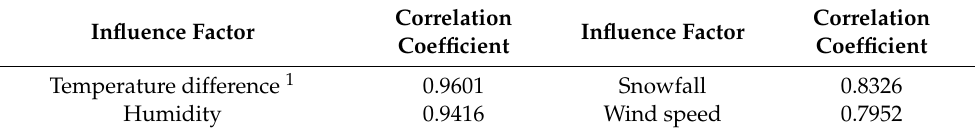
1 Table notes: In this paper and Table 1, “temperature difference” refers to the difference between human thermal comfort temperature and actual temperature.